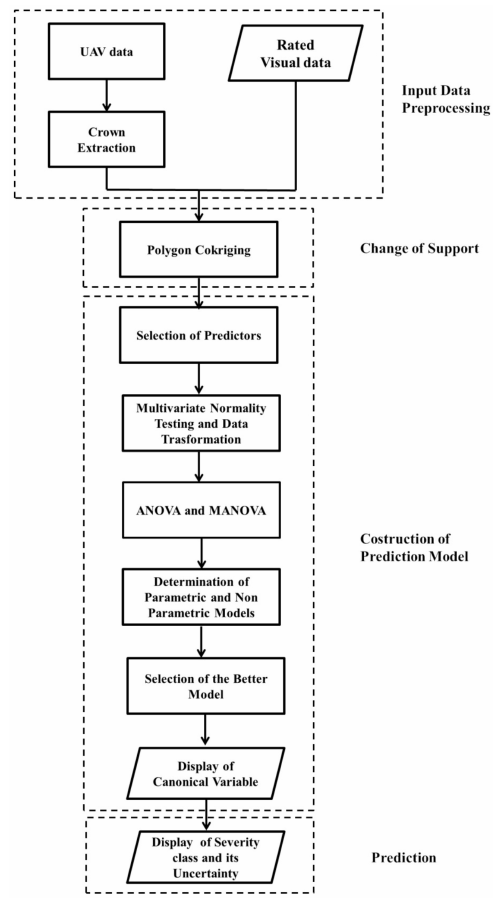
Figure 7. Flowchart of the proposed geostatistical-discriminant